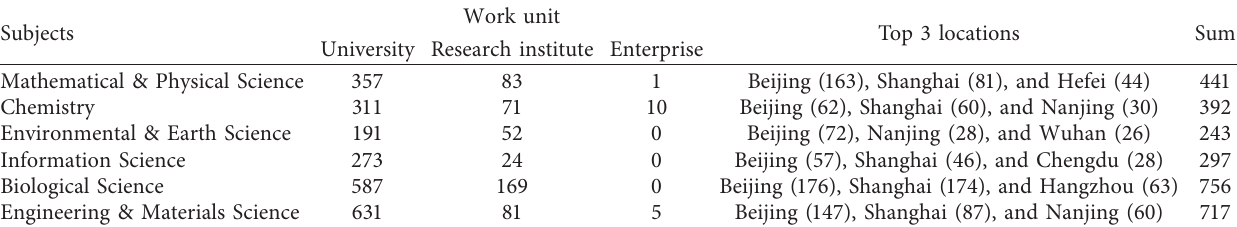
Table 1: Descriptive statistics of location